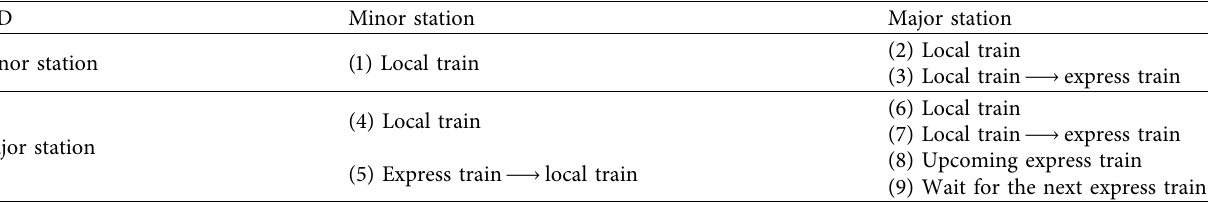
Table 2: Passenger route selections under different